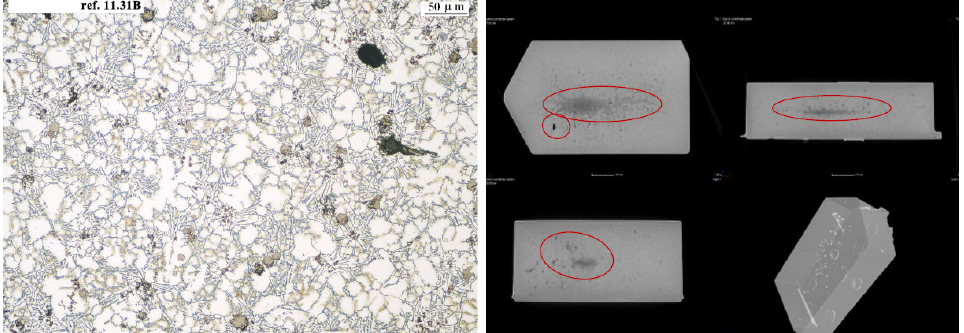
Figure 11. Micrography ( left ) and tomography results ( right